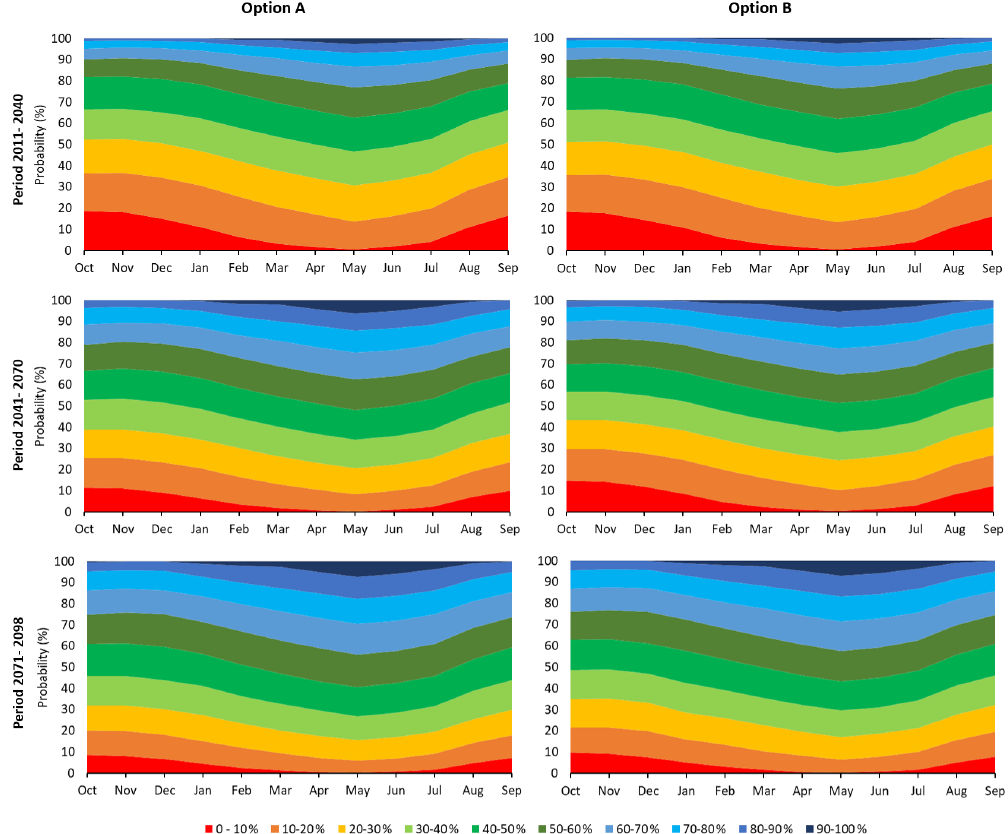
Figure 8. Drought risk indicator of the ensemble mean per option (A and B) and future period (2011–2040, 2041–2070, and 2071–2098).